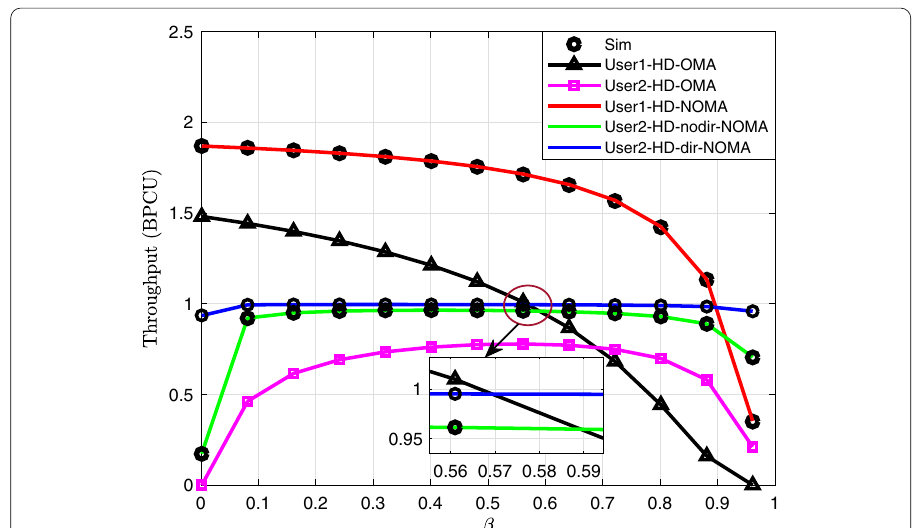
Fig. 5 The throughput of two users versus β in cases of no direct link and direct